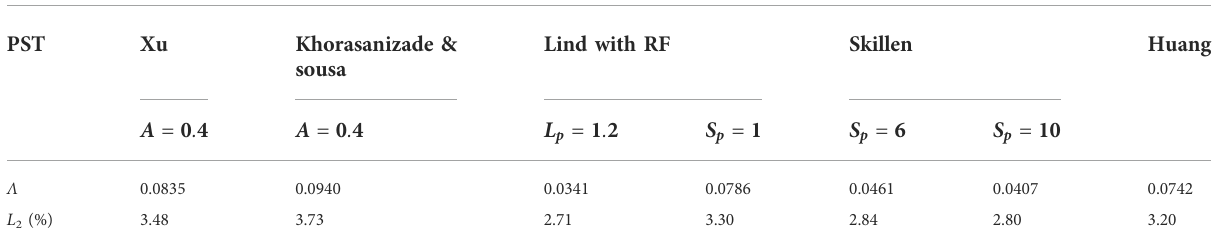
TABLE 3 Comparison of numerical results of different PSTs.